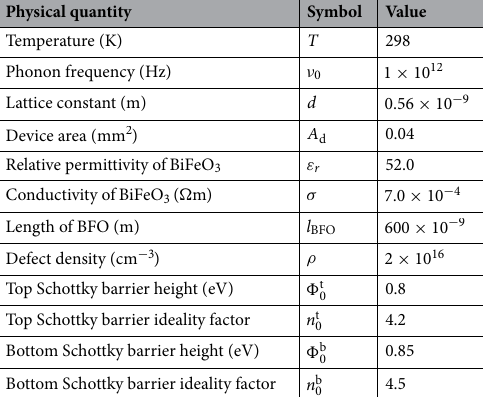
Table 1. Details of the simulation parameters.